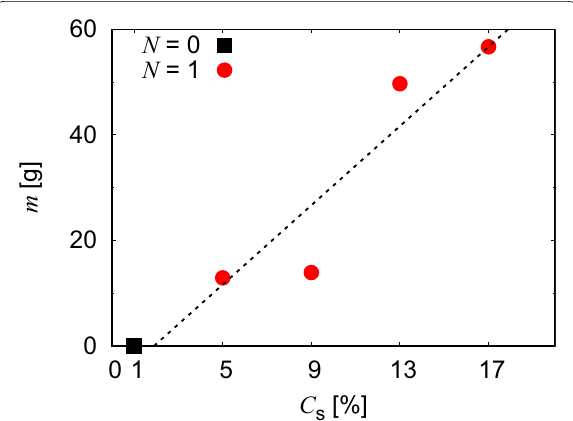
Fig. 7 Aggregate formation according to amount of snow. Influence of snow concentration, C s , on number and mass of aggregates, N and m , in EXP2 ( d t = 32 – 63 µ m , C t = 33% , and t = 20min ). The dashed line is a fitting line: m = 3.76 C s −